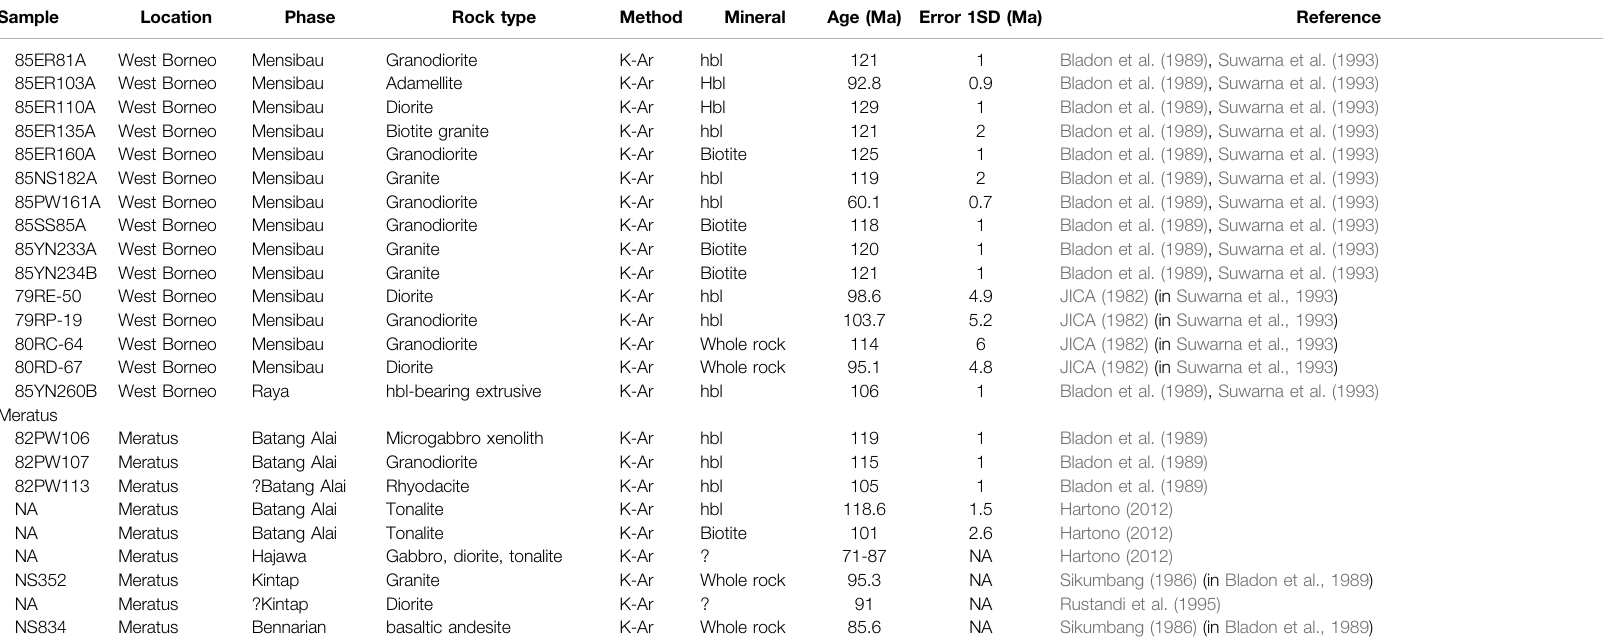
TABLE 1 | ( Continued ) Literature age data of Jurassic to Cretaceous rocks of the Schwaner Mountains and western Borneo. Phases marked with * are here reinterpreted based on their ages compared to their original